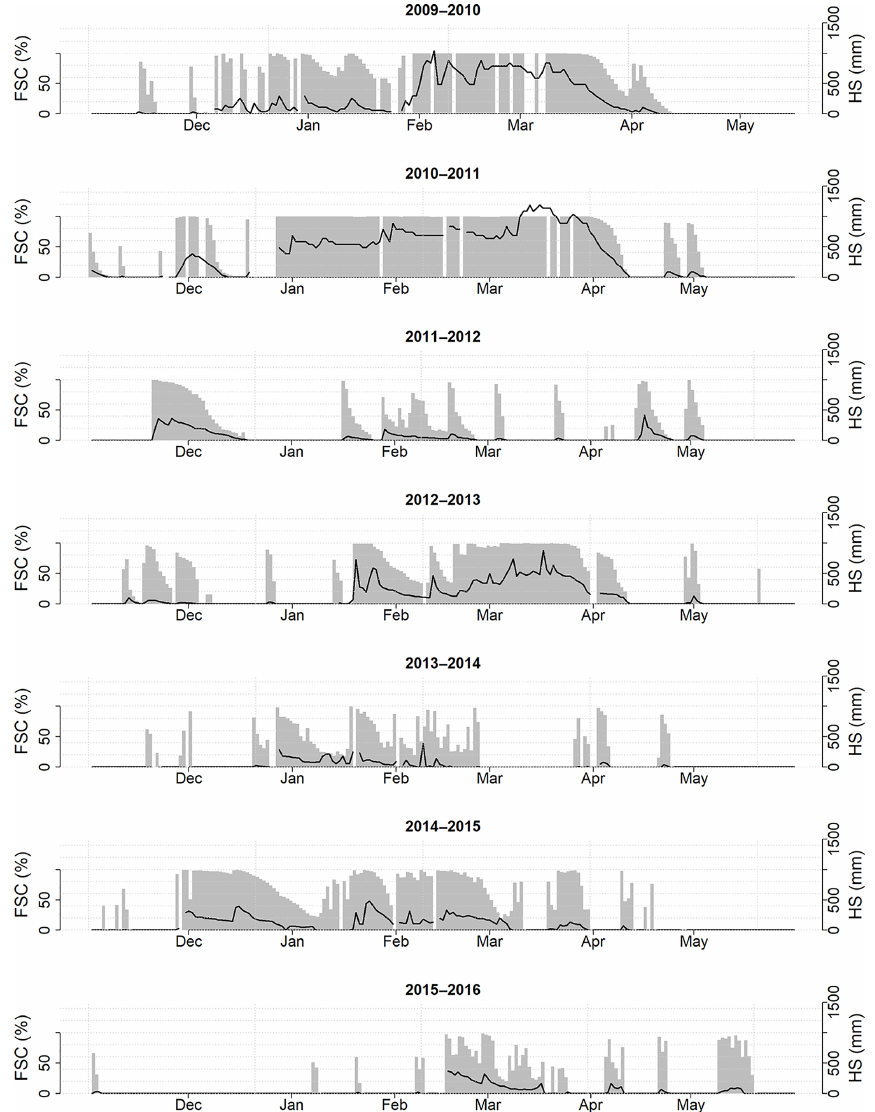
Figure 6. Snow variables retrieved from the images of the time-lapse camera C2 in the Guadalfeo Network. Evolution of the observed daily fractional snow cover (FSC) and height of snow (HS) from the 30m × 30m scene during the snow season (1 November–31 May) during each hydrological year of the period